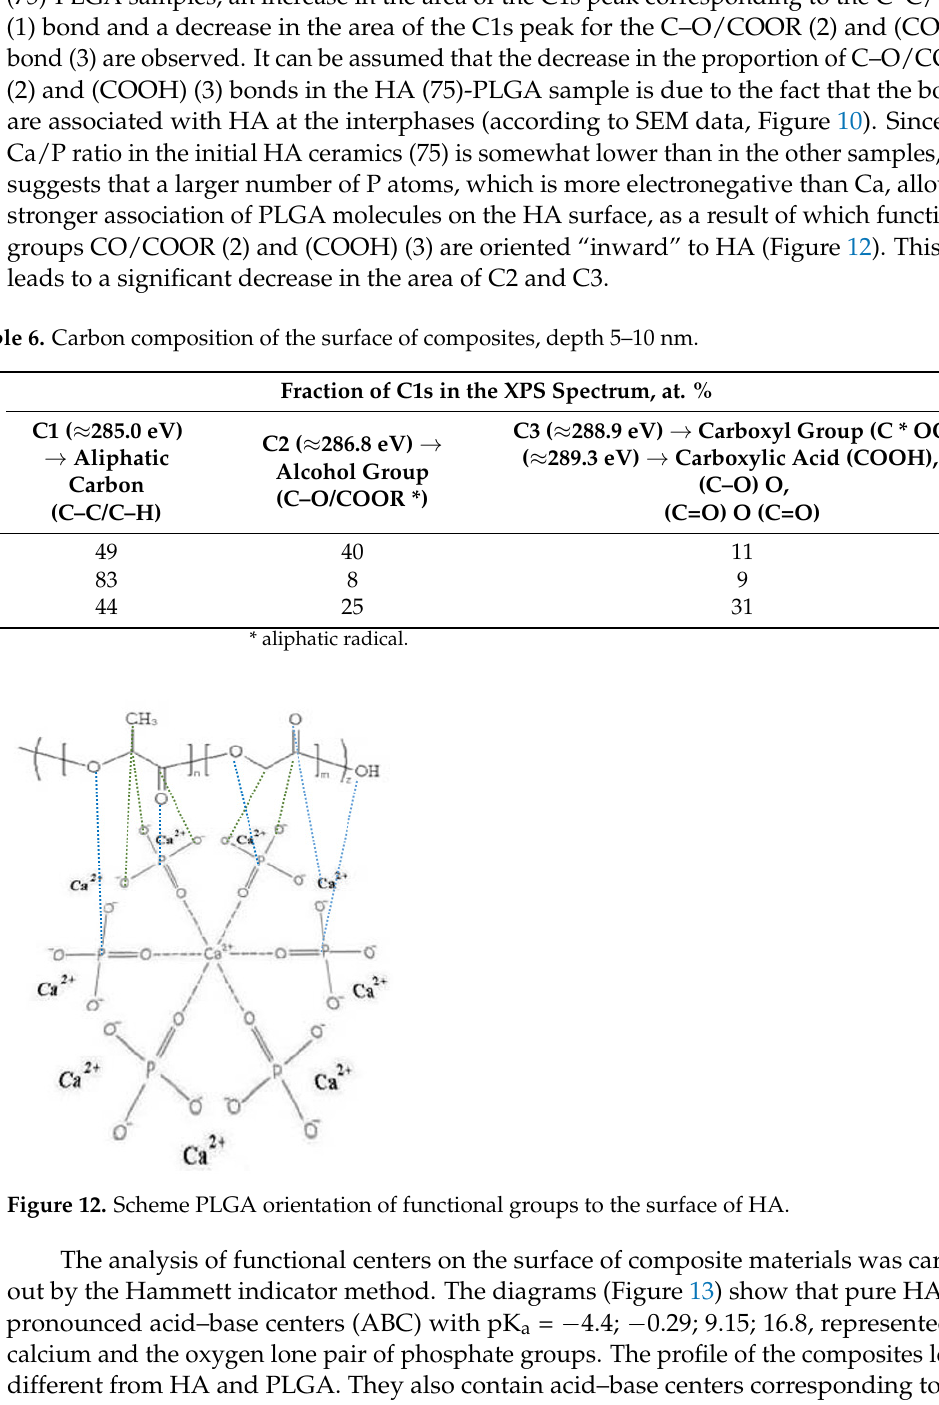
Table 5. Elemental composition of the surface of composites, thickness 5–10 nm.